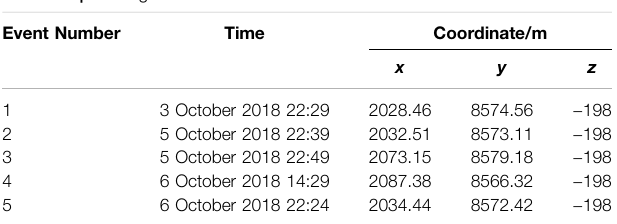
TABLE 4 | Blasting test location.